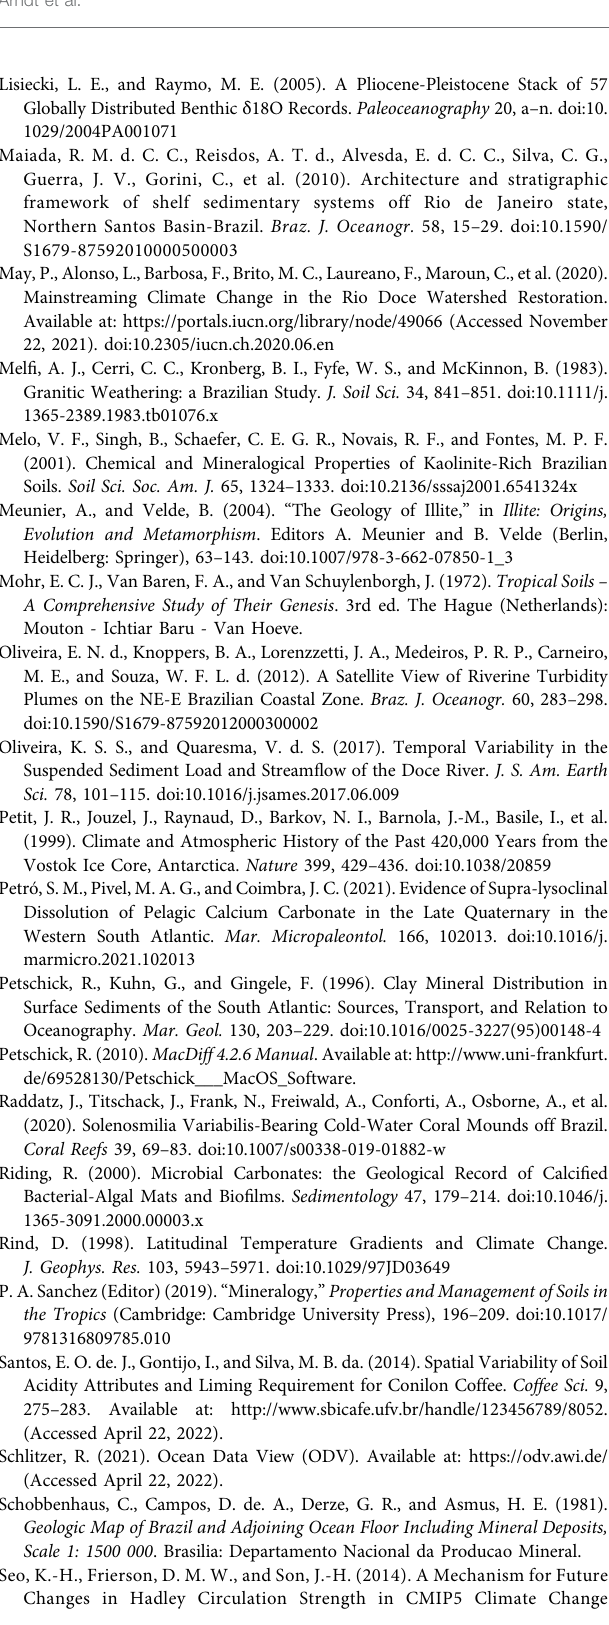
Scale 1: 1500 000 . Brasilia: Departamento Nacional da Producao Mineral. Seo, K.-H., Frierson, D. M. W., and Son, J.-H. (2014). A Mechanism for Future Changes in Hadley Circulation Strength in CMIP5 Climate